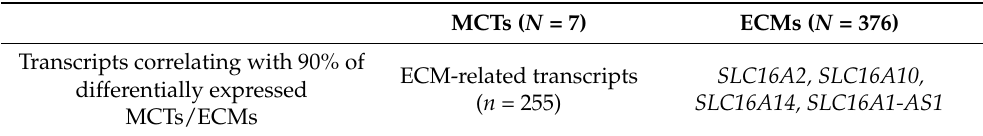
N indicates the number of MCT or ECM transcripts in the hypernetwork clusters.